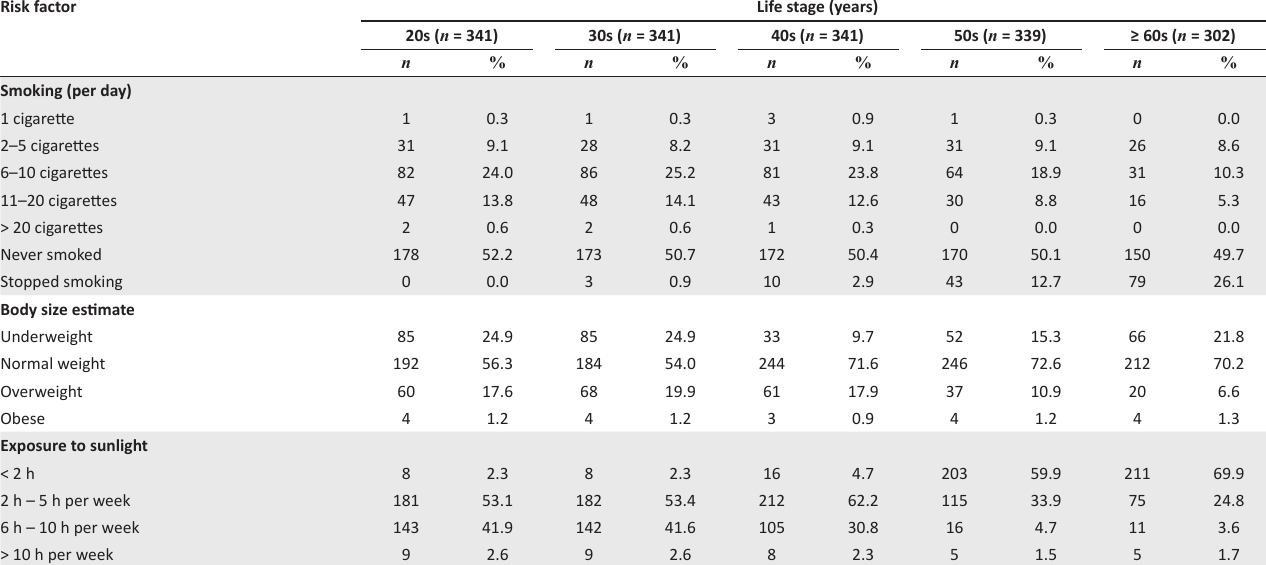
TABLE 2: Smoking, body size and exposure to sunlight. Risk factor